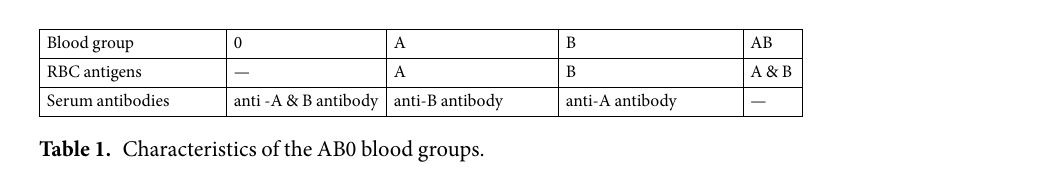
Figure 1. RBC dimensions and design of microfluidic chamber. ( a ) A scanning electron microscopic picture and a cross-sectional view of a red blood cell that indicates it’s shape and average dimensions. ( b ) The photo shows the capillary system filled by blood. ( c ) The microfluidic device was formed by aligned attachment of PDMS-PEO based flow cell containing microfluidic channels onto slides functionalized by anti-A and anti-B reagents in the indicated regions. The left panel presents the cross-sectional view of the winding channel.